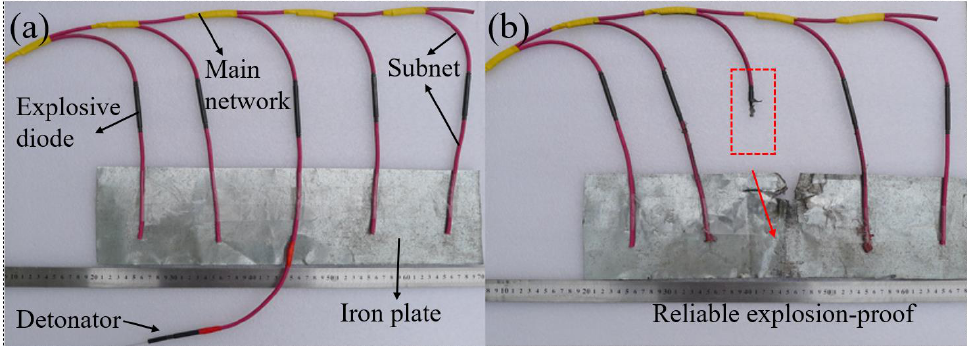
Figure 11. Network of the explosion-proof experiment ( a ) and results ( b ).